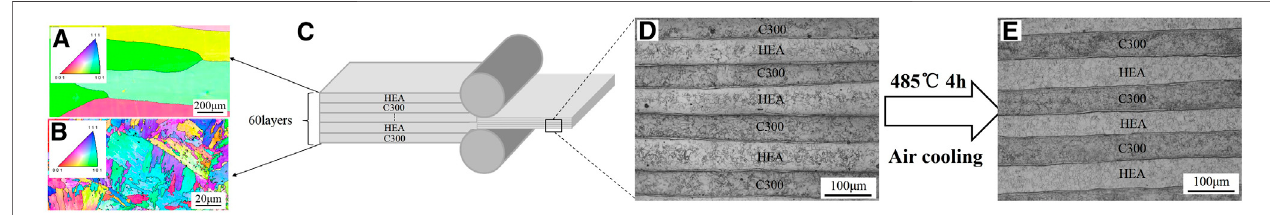
FIGURE 1 | (A,B) Inverse pole fi gure the IPF mapping of original the original CoCrNi alloy and C300. (C) a schematic diagram of the hot-rolling process, (D,E) the optical microstructures of the hot-rolled and aged multilayer maraging/CoCrNi composite.